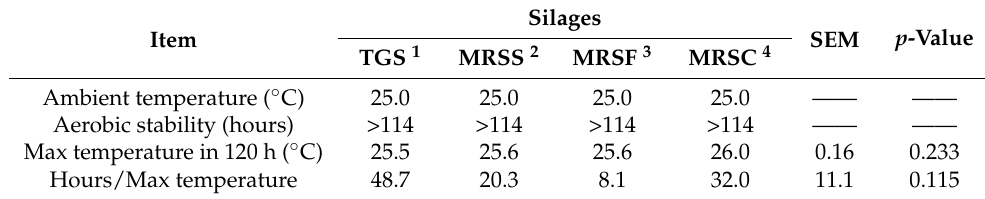
Table 5. Maximum temperature and aerobic stability in dairy cow diets after 114 h of exposure.